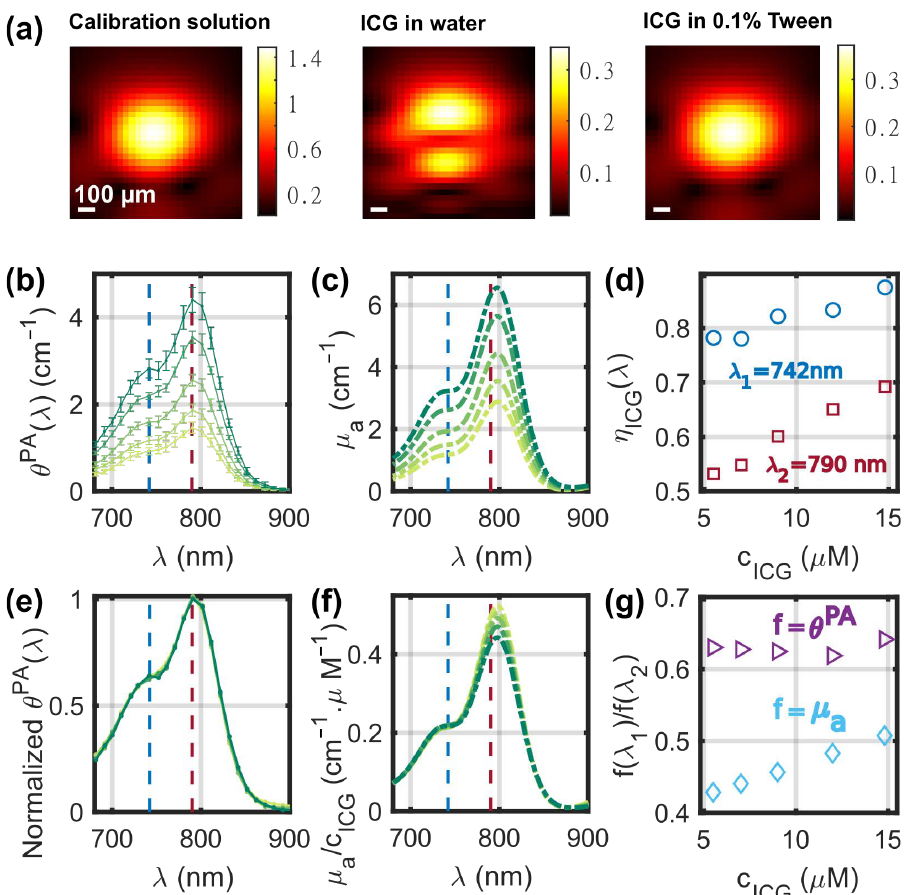
Figure 9. Experimental results for the solutions of indocyanine green (ICG). ( a ) PA images at 790 nm of a tube filled successively with: (left) the calibration solution, (middle) a solution of ICG in DPBS with 1% DMSO, and (right) a solution of ICG in DPBS with 1% DMSO and 0.1% Tween 20. The color scales are in arbitrary units. ( b ) PA coefficient θ PA (median ± MAD) and ( c ) the corresponding µ a spectra for the different concentrations of ICG. ( d ) Photoacoustic generation efficiency evaluated at two wavelengths, λ 1 = 742 nm and λ 2 = 790 nm, as a function of the concentration of ICG. ( e ) Median PA spectra of ( b ) normalized to their maximum value. ( f ) µ a spectra of ( c ) normalized by concentration in ICG. For ( b – f ), the color of the curves changes from light green to dark green with increasing concentration. ( g ) Ratios θ PA ( λ 1 )/ θ PA ( λ 2 ) and µ a ( λ 1 )/ µ a ( λ 2 ) as a function of the concentration of